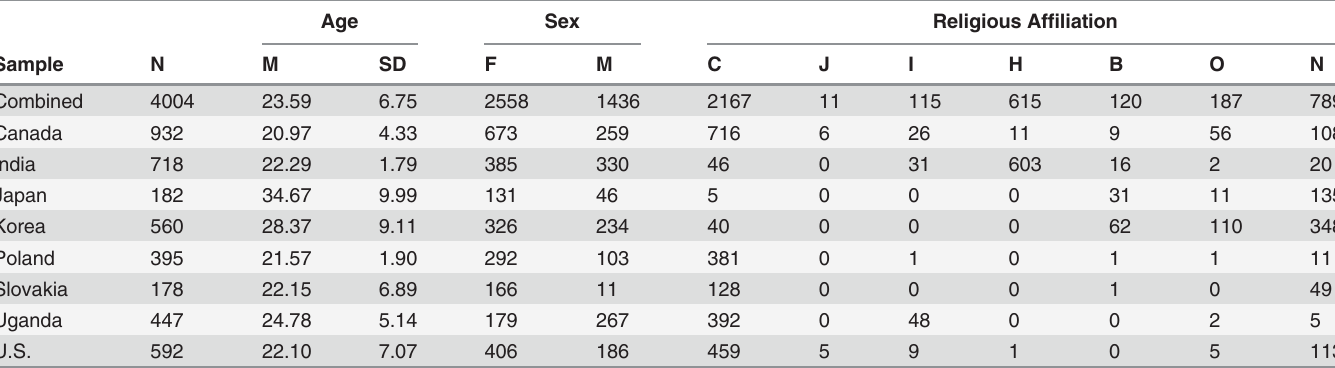
Table 1. Description of Demographic Characteristics of Samples After Data Cleaning.